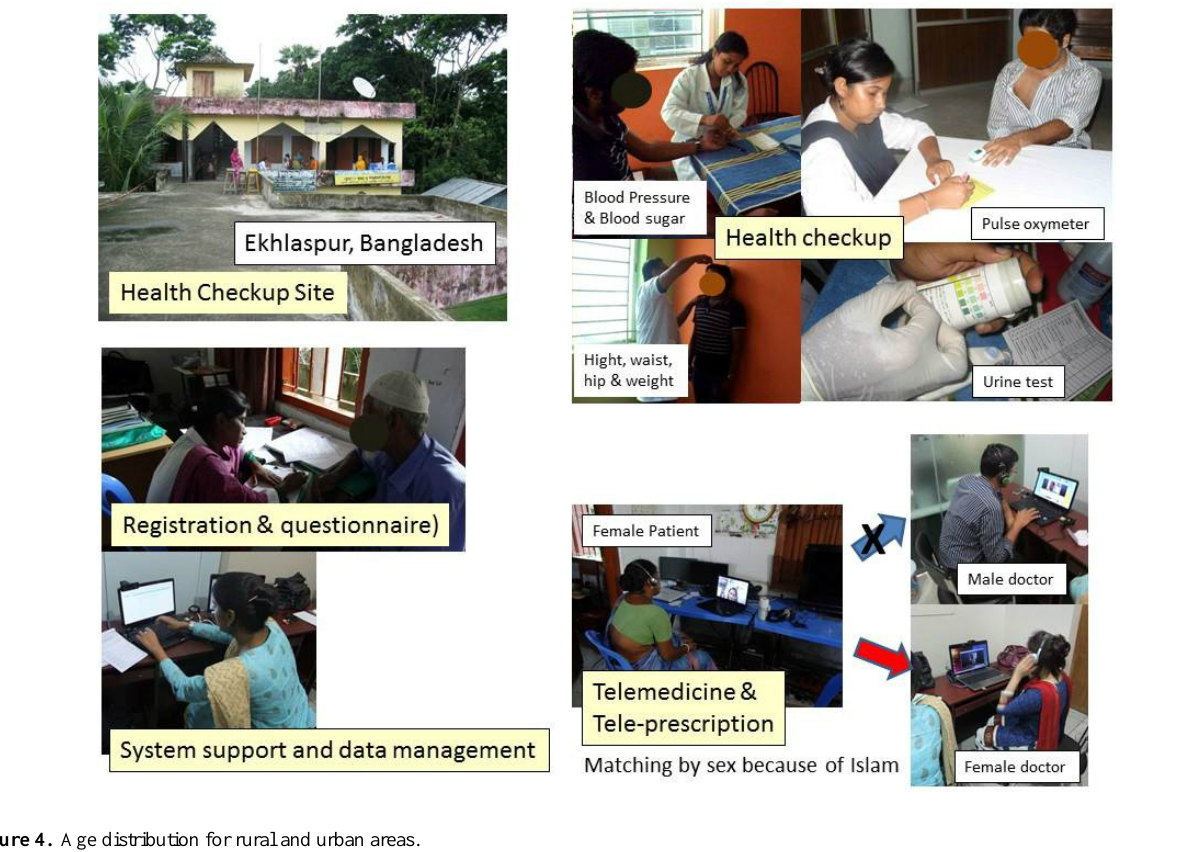
Figure 3. Images of a health checkup and teleconsultation.